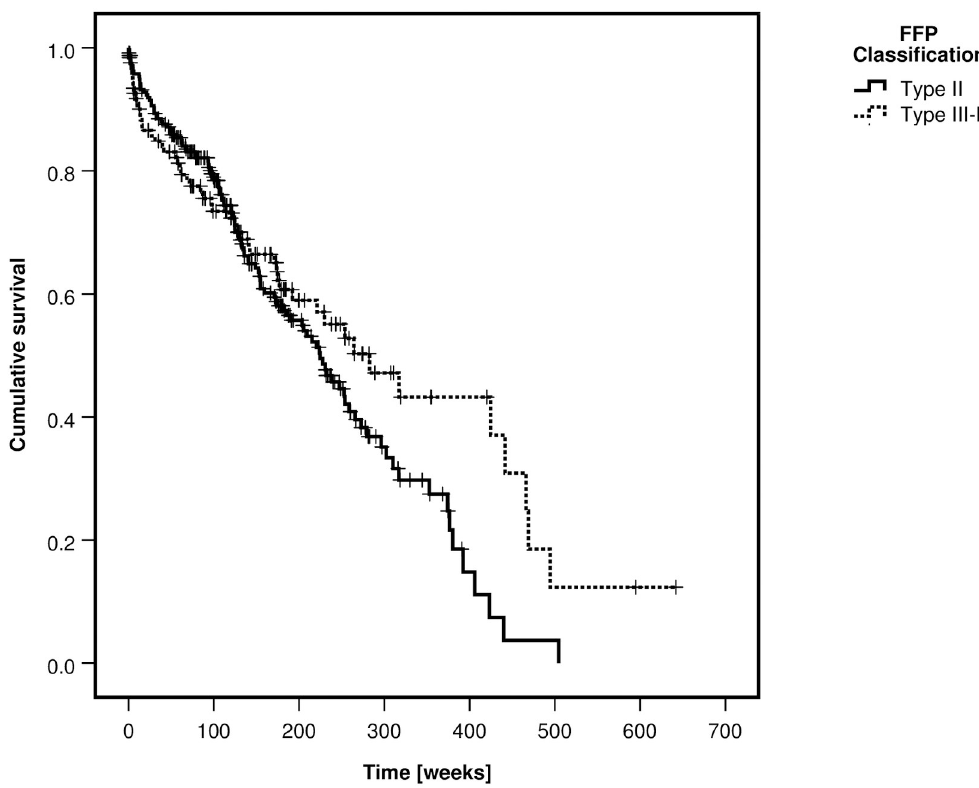
Fig 3. Kaplan-Meier curve of cumulative survival, depending on FFP-classification—All patients.